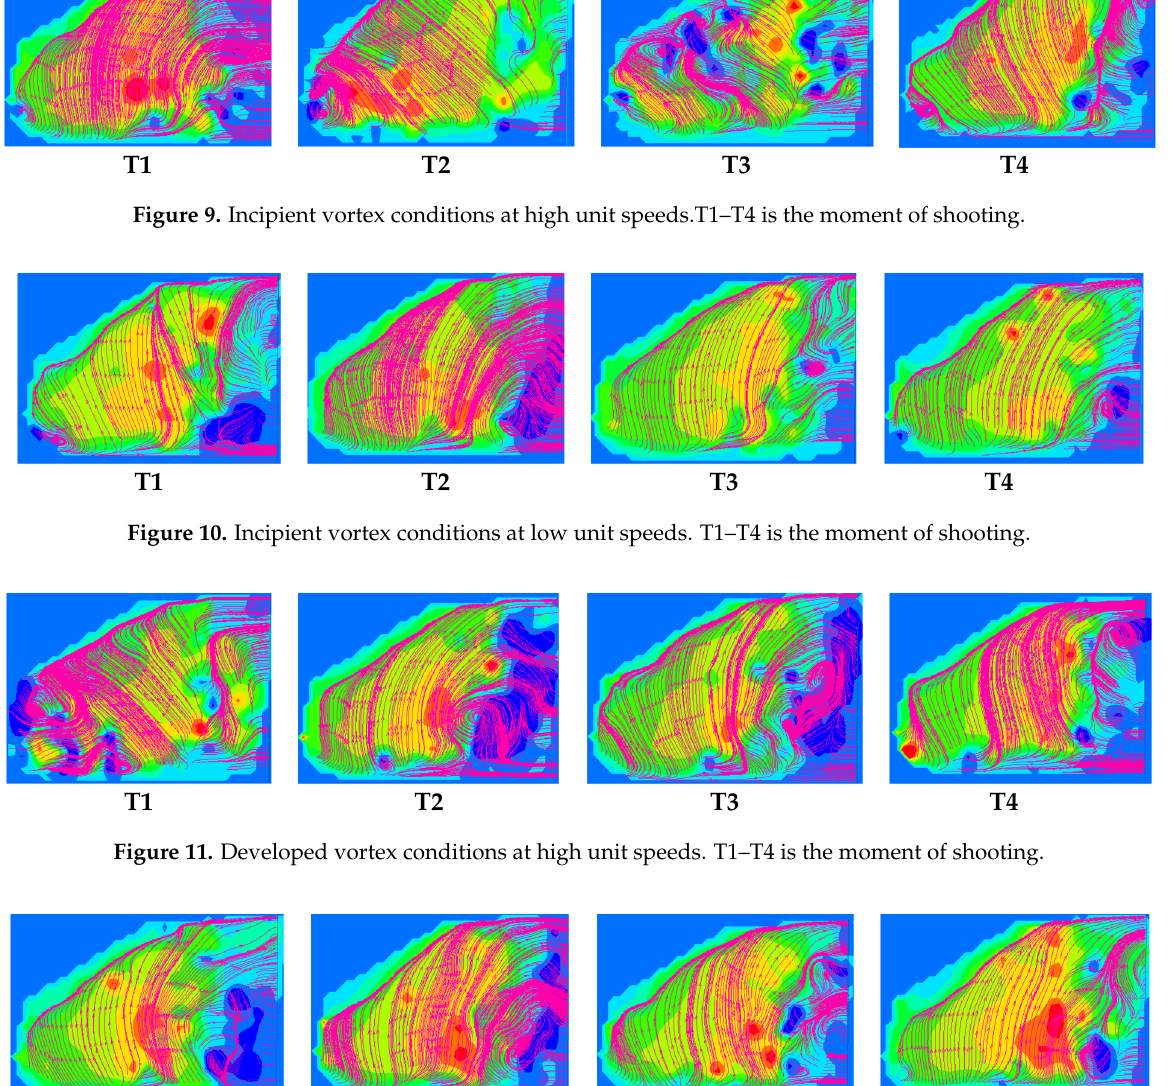
Figure 12. Developed vortex conditions at low unit speeds. T1–T4 is the moment of shooting